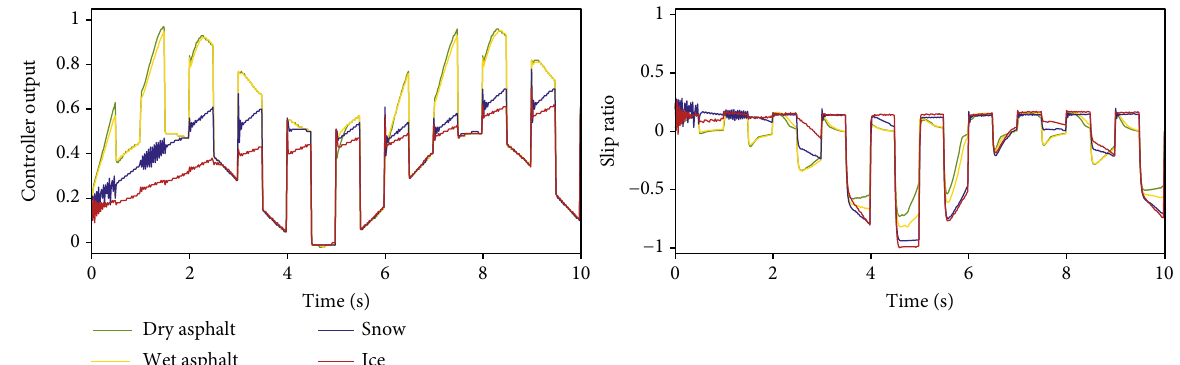
Figure 7: Comparison of the chosen controllers.